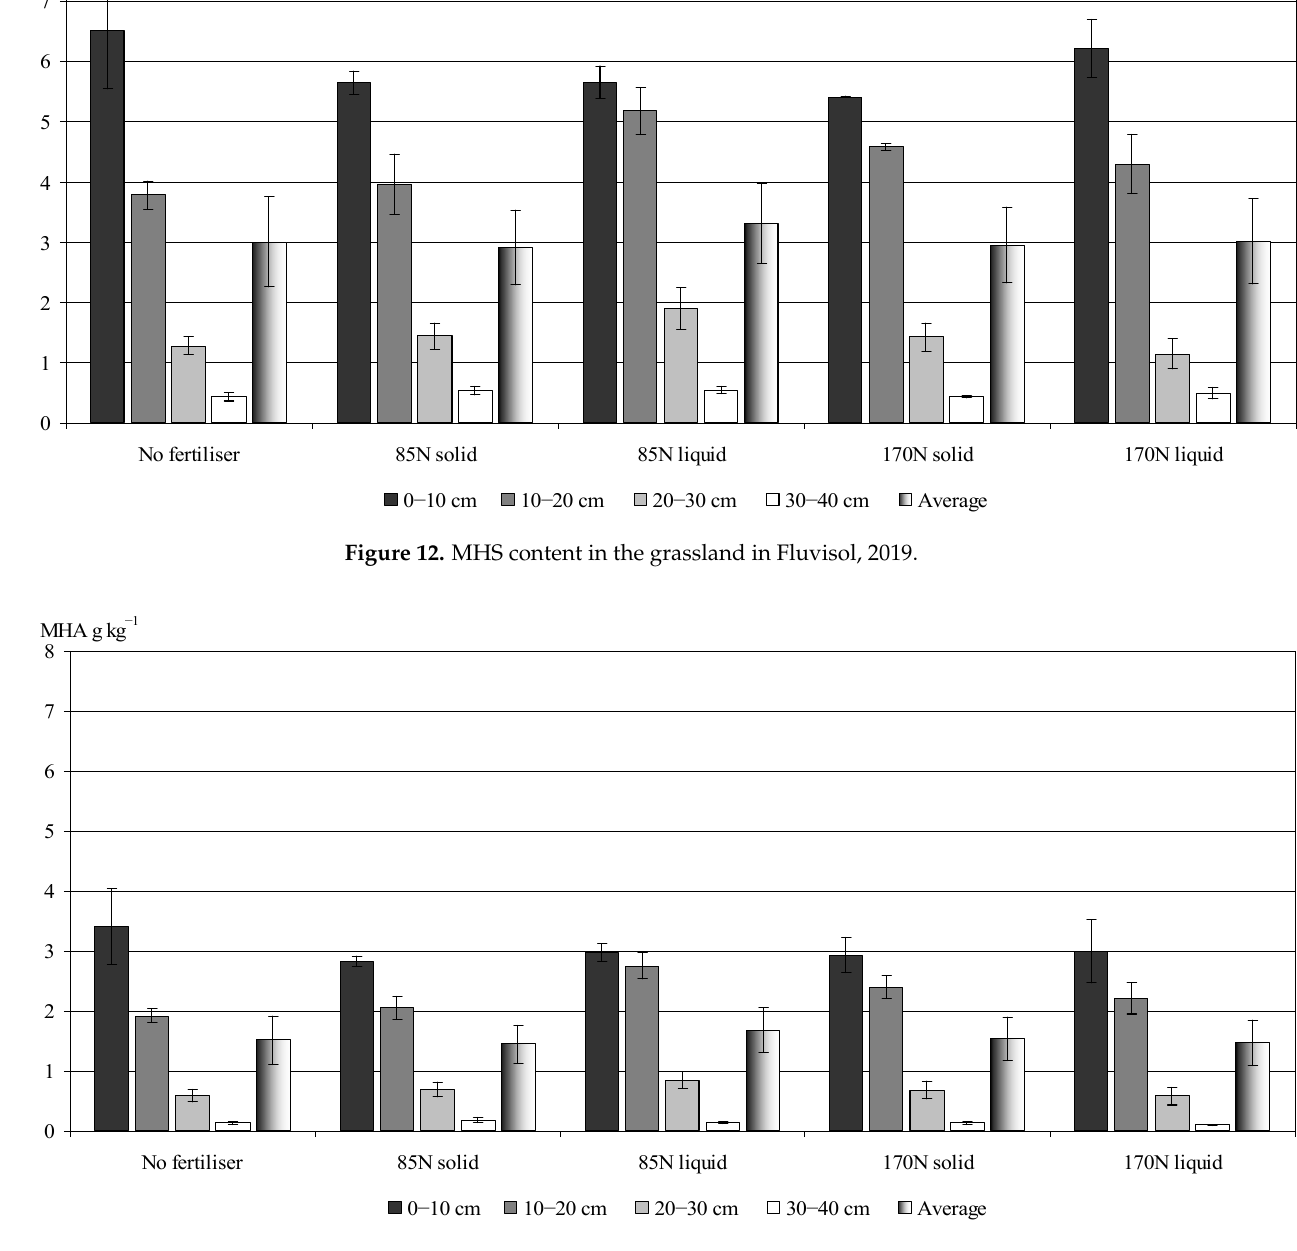
Figure 13. MHA content in the grassland in Fluvisol, 2019 .